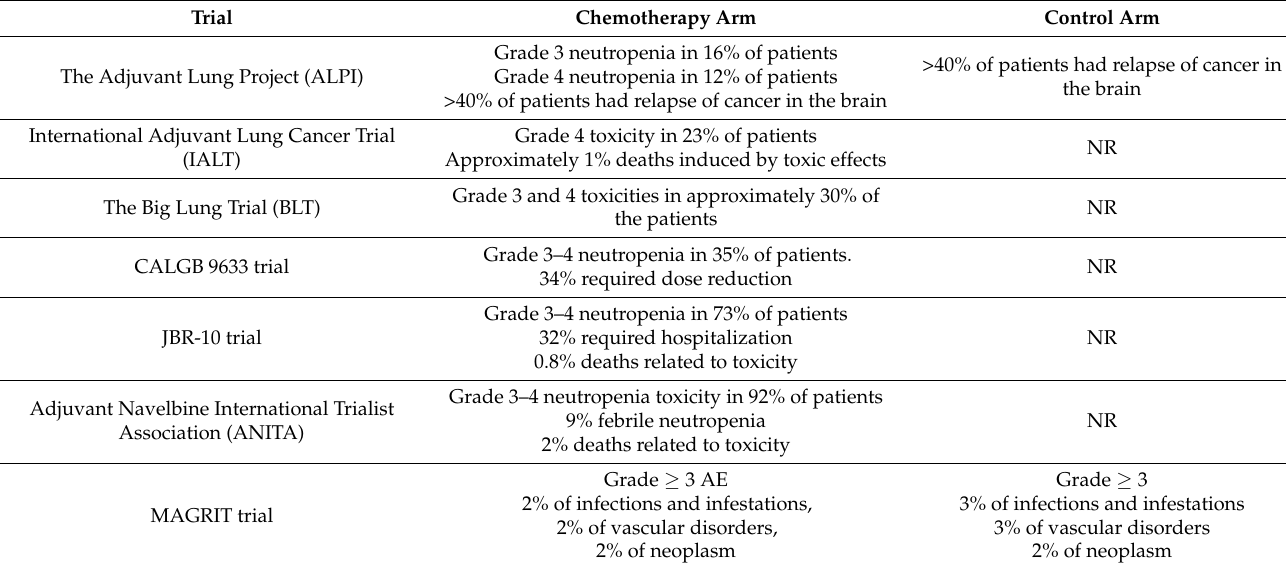
Table 3. Adverse events (AE) reported in past clinical trials that included adjuvant therapy uncharacterized for EGFR status in patients with completely resected